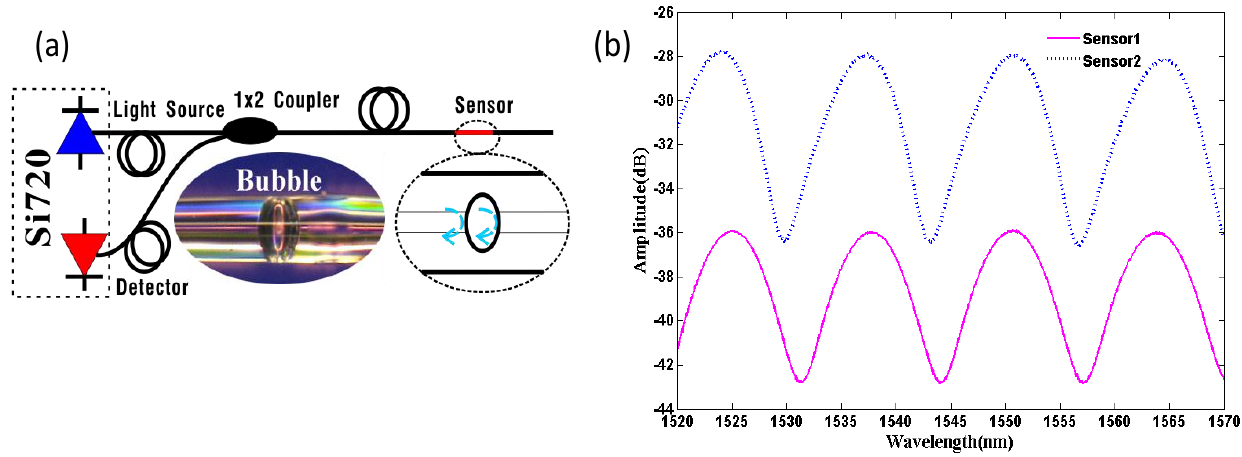
Figure 5. The air-bubble-based FPI sensors with cavity length of 91 μm: ( a ) schematic, inset picture is the microscope photograph; ( b ) reflection